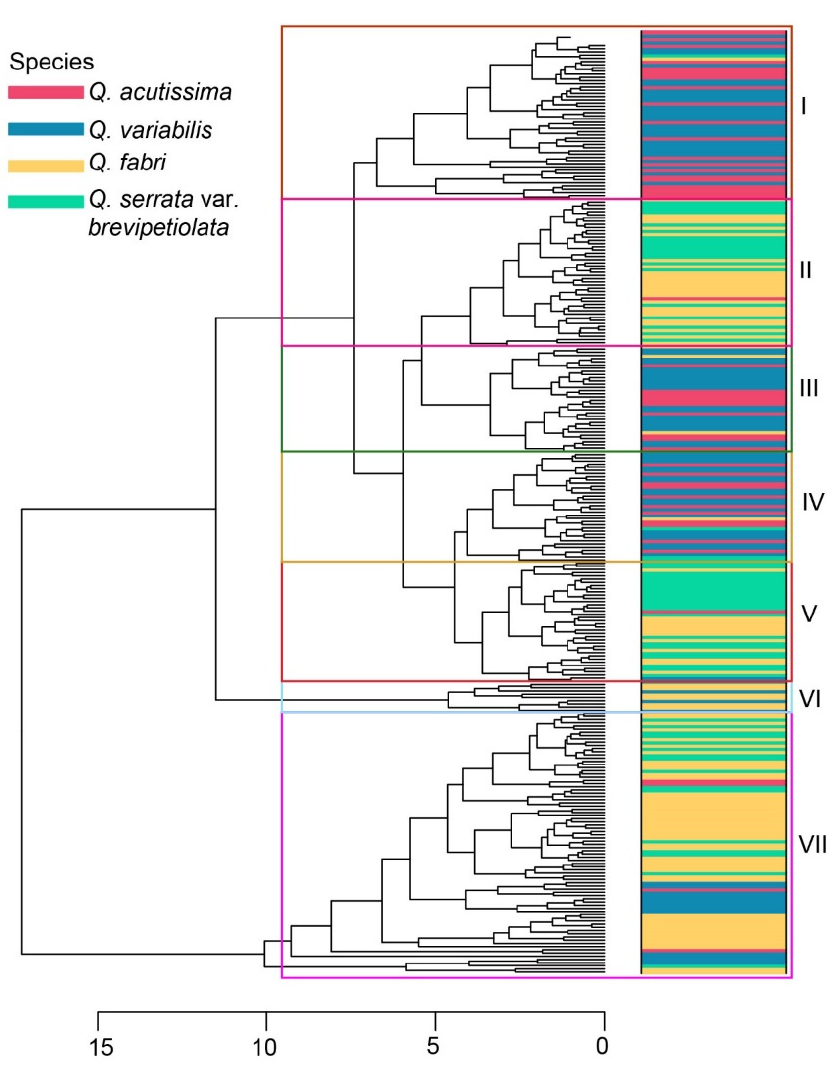
Figure 8. Hierarchical clustering of leaf phenotypic traits for the four-oak species.